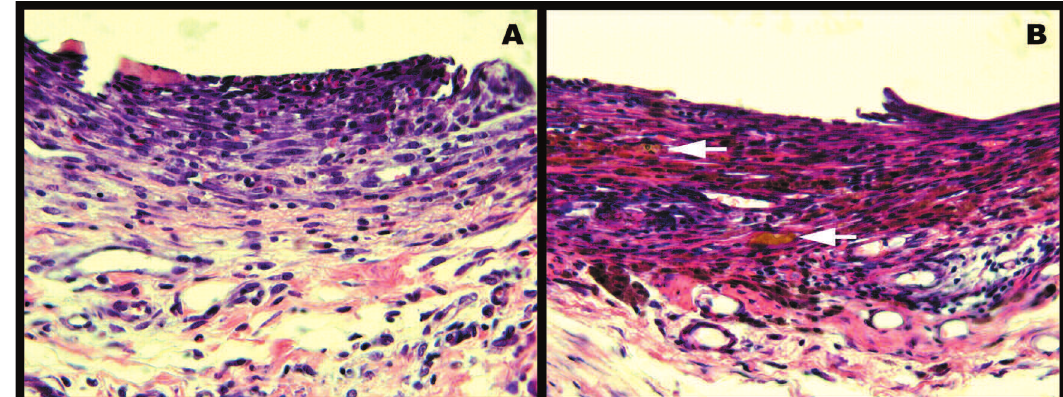
Figure 5- Aroeira’s ethanolic extract group. A – At 7 days, the granulation tissue is thick and presents macrophages, (-;#<7&-$*,)'+?)8'8*)+*>$87#<%(,3)N(77?)G*,,*(,))'8*)?%,$8%K>$*?)'(()7G*8)$<*)$%,,>*)'+?)$<*)LK87K(',$,)'8*)+*'8)?%,78='+%M*?) &7(('=*+)LK*8,)'$)$<*)#*8%#<*8-)79)$<*)$%,,>*3)N)O)C$)PQ)?'-,F)$<*)&7++*&$%G*)$%,,>*)%,)$<%+)R%$<)8'8*)%+:';;'$78-)&*((,3)N(77?) vessels are distributed along the granulation tissue. Arrows point a hemorragic area pigmented by hemossiderin.